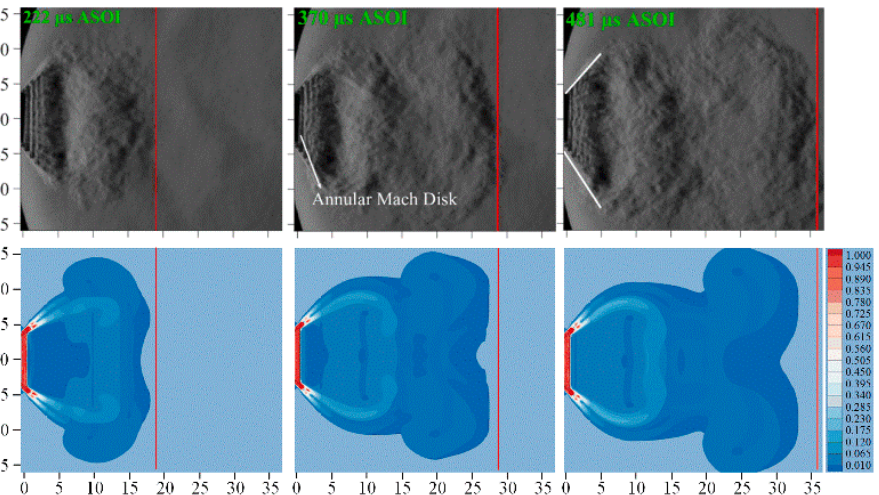
Figure 6. Instantaneous injection flow features during the injection, shown with Schlieren imaging [22] (first row) and simulation results using the density gradient method (second row).